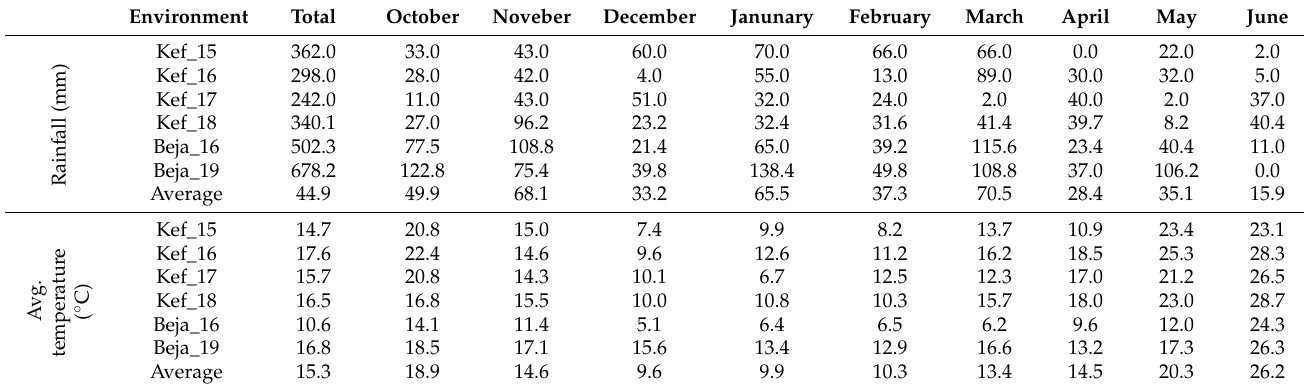
Table 3. Climatic variations across the six tested environments in Kef and Beja sites.